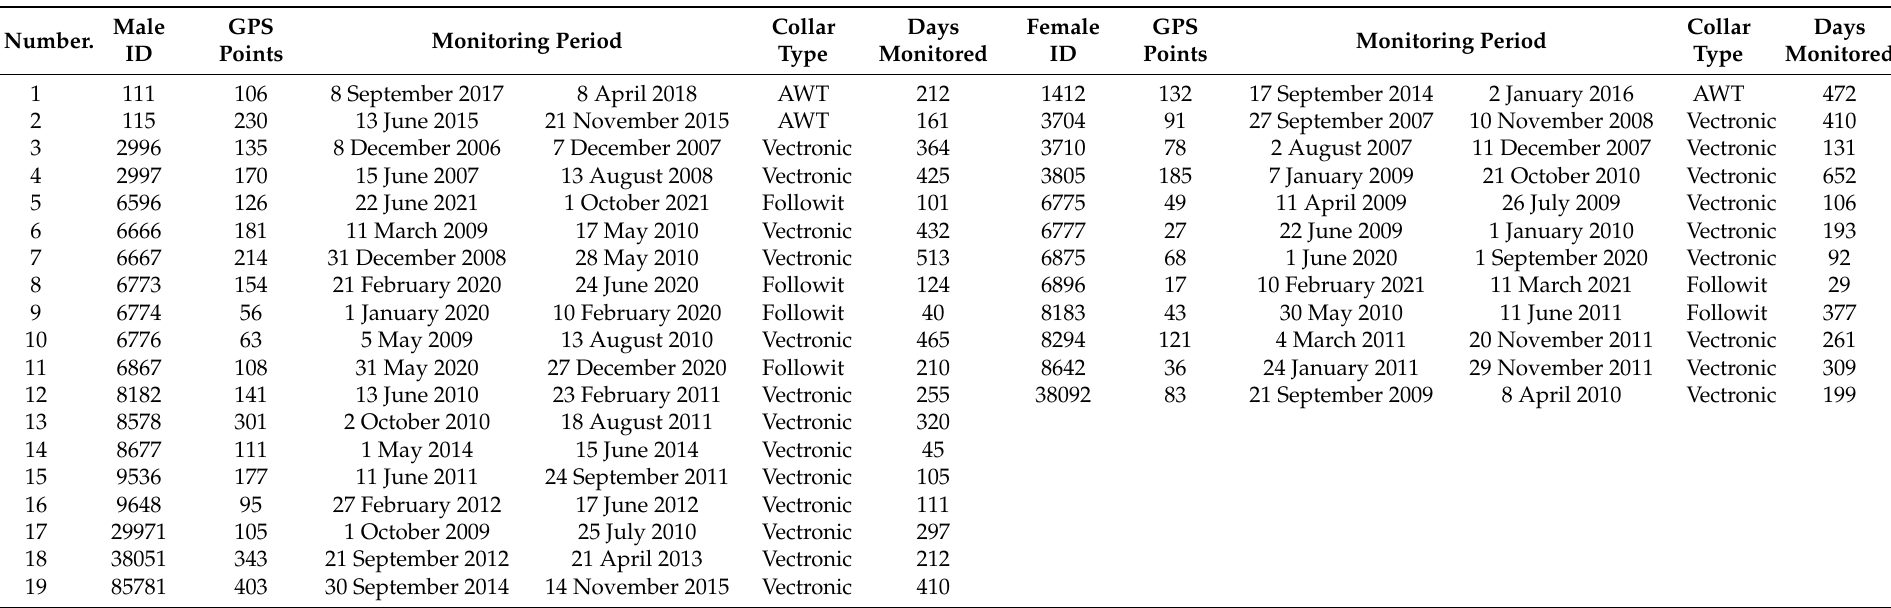
Table 1. Summary of GPS collar data collected from individual male and female leopards collected between 2007 and 2021 used to predict leopard